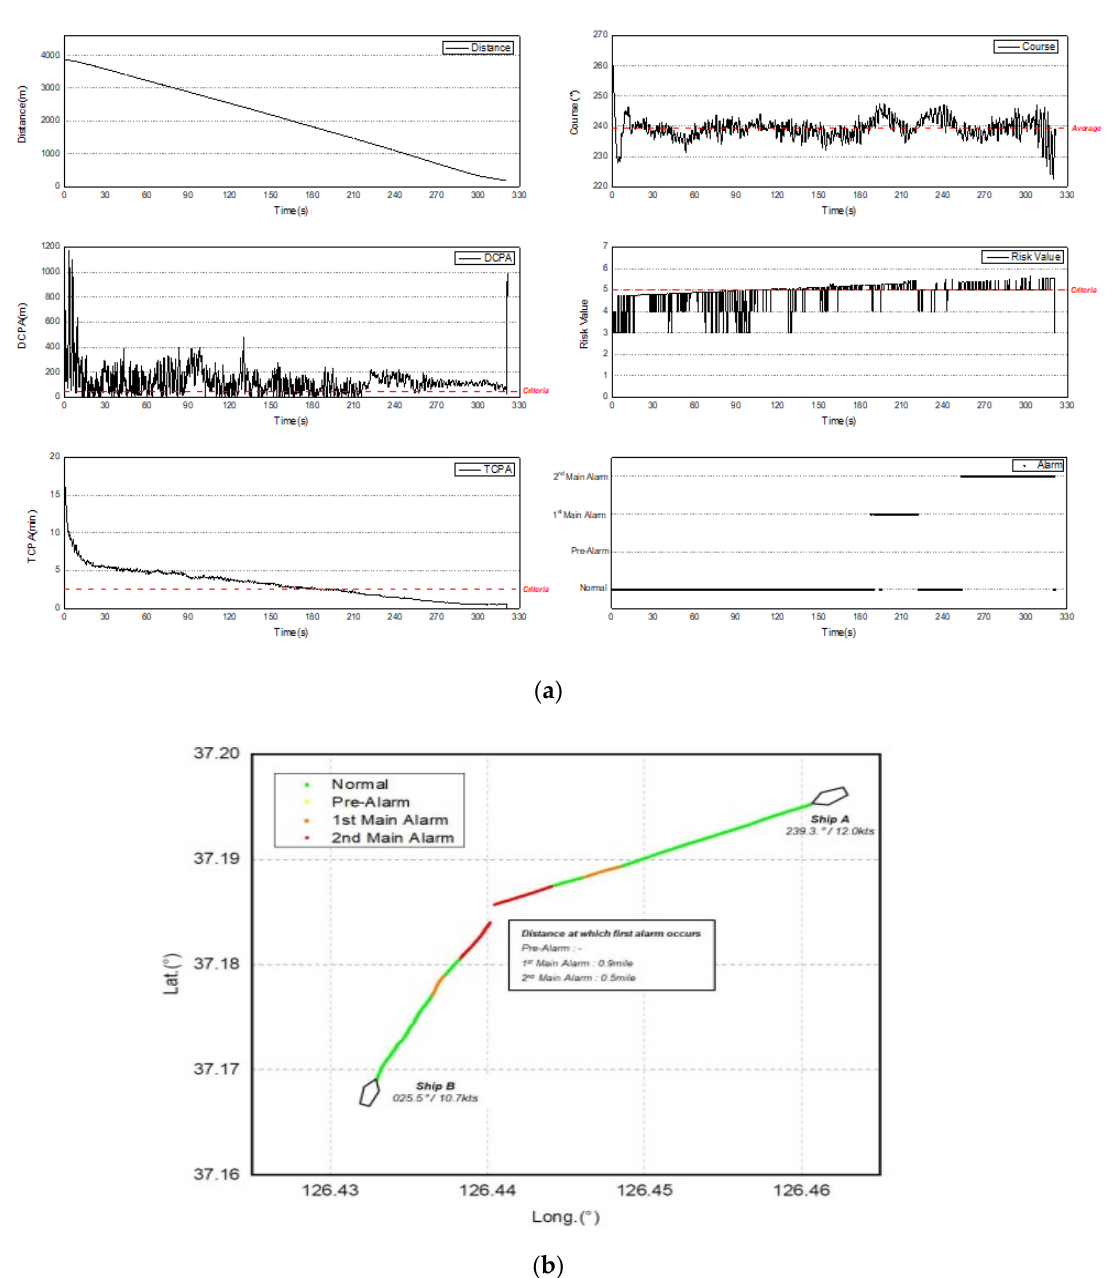
Figure 12. ( a ) Experimental results; ( b ) track and alarm analysis for S 2